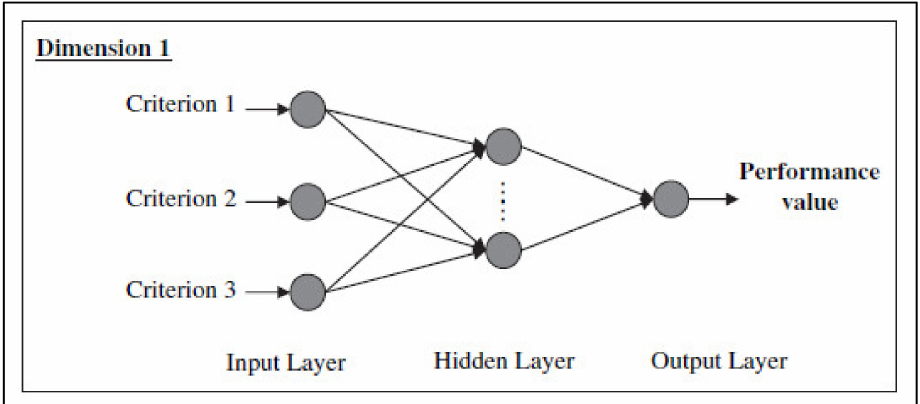
Figure 5. Network